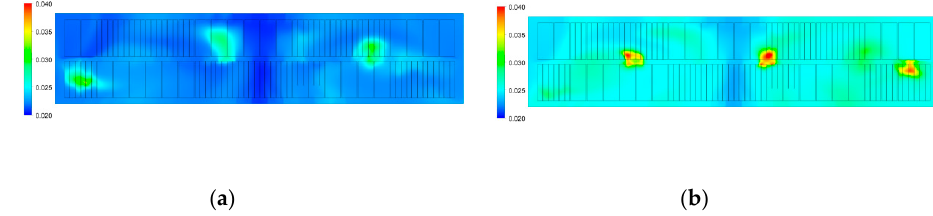
Figure 10. Alumina distribution in a horizontal plane in the middle of ACD for the unslotted case 1: ( a ) t = 2700 s, ( b ) t = 4800 s.